Question: What does this figure show? Answer in one sentence.
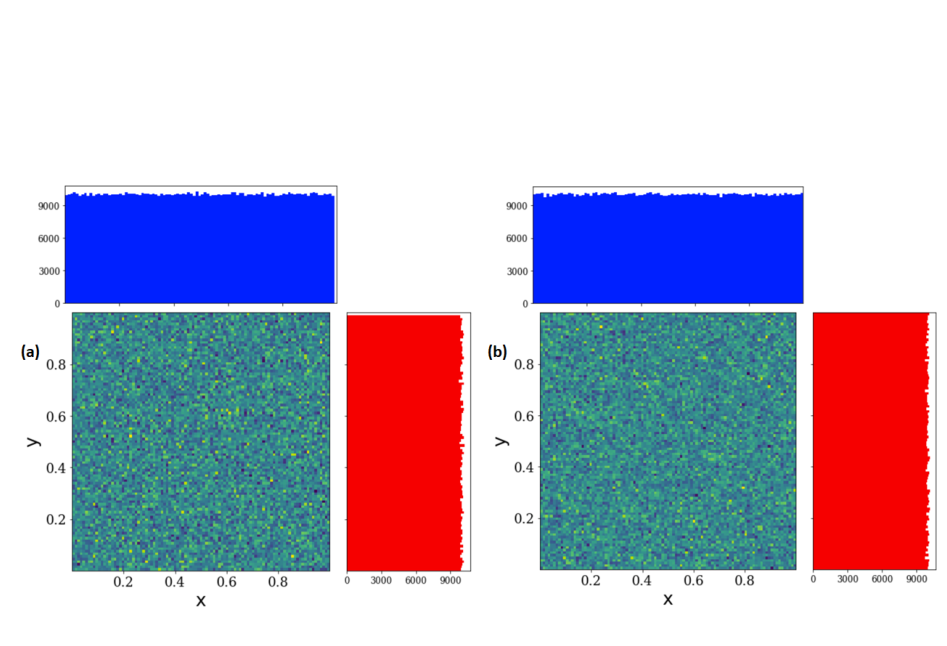
Answer: The 2-dimensional histogram analysis for two variables x and y. Also shown are the 1 dimensional histogram analysis for x (top) and y (right) respectively. For a random sequence array, such as rand[0:1000000], x =rand[0:-1], and y =rand[1:]. The a) is for the pseudo random num- bers generated on WSE, and b) is for the pseudo random numbers generated from numpy by using numpy.random.rand.